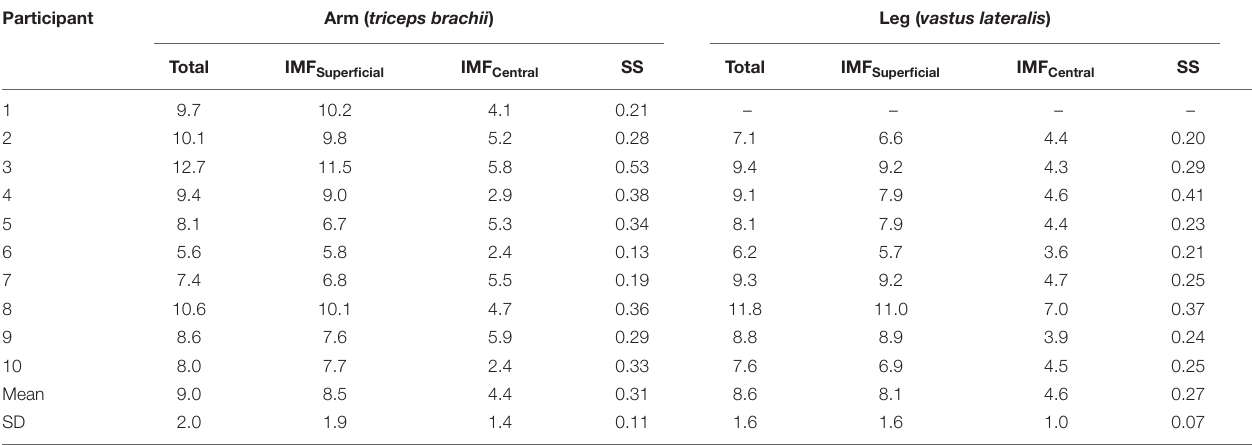
TABLE 5 | The volume of mitochondria – total and in the superficial and central intermyofibrillar space (IMF) and the sarcolemmal space (SS) – in the arm and leg muscles of elite cross-country skiers ( n = 10). Participant Arm ( triceps brachii )